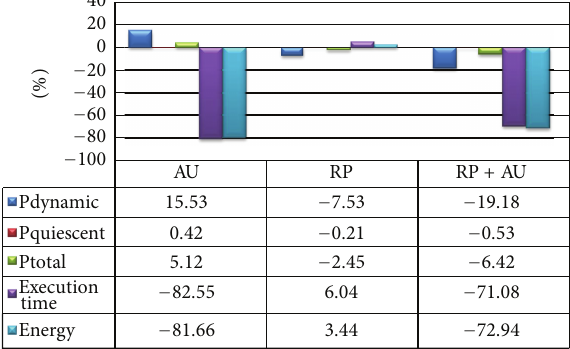
Figure 24: Impact of the MicroBlaze configurations for the NCC algorithm. Table 6: Impact of the MicroBlaze configurations for the NCC algorithm at 100MHz for V4FX100.